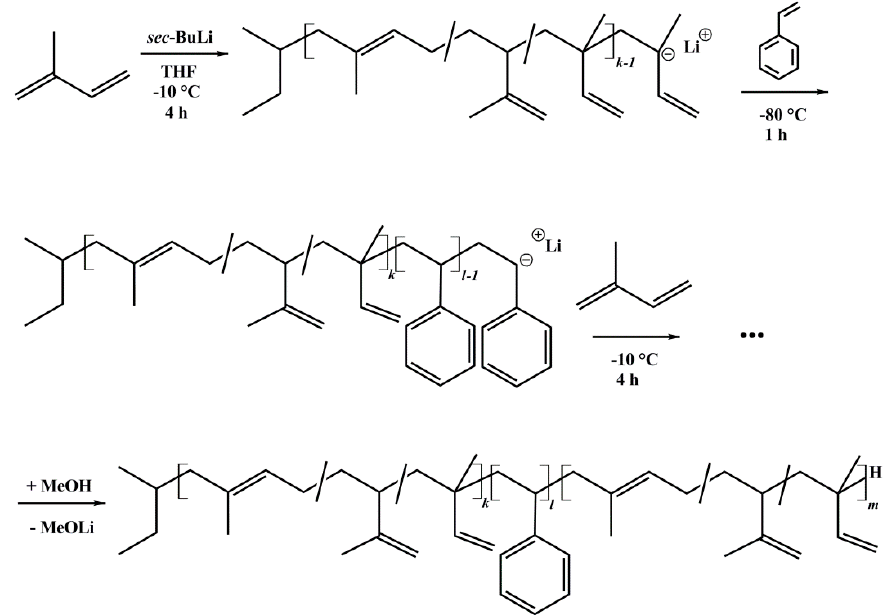
Figure 2. Reaction scheme of ISI triblock copolymers, synthesized via anionic polymerization in THF using sec ‐ butyllithium as initiator.